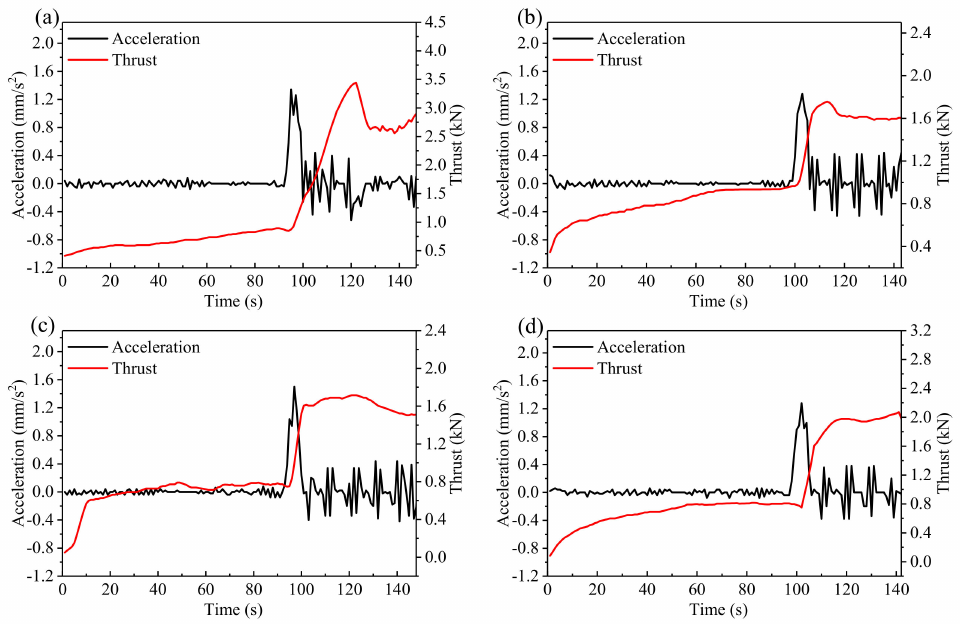
Figure 10. Acceleration and thrust plotted against time in ( a – d ) for the four experiments. All data points are the moving average value of 5